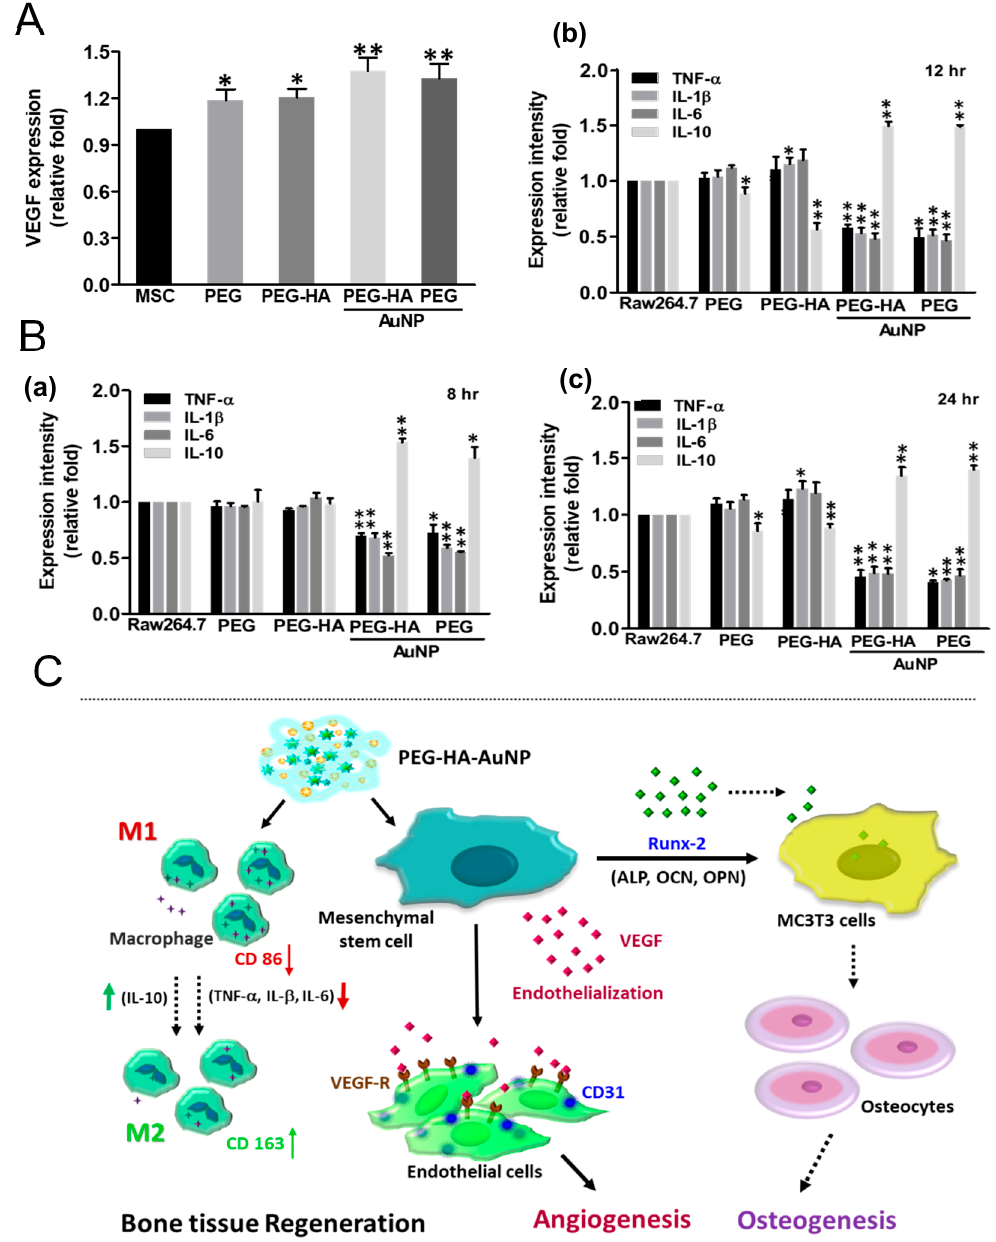
Figure 8. Assessment of the immune response and angiogenesis of MSCs on different materials. ( A ) Measurement by ELISA assay shows significantly increased VEGF protein expressions for MSCs after culture on different materials after 48 h of incubation. Data are mean ± SD. * p < 0.05: ** p < 0.01: greater than TCPS. ( B ) ELISA results for inflammatory cytokines: ( a ) 8 h, ( b ) 12 h, and ( c ) 24 h of production by RAW264.7 cells. * p < 0.05; ** p < 0.01. ( C ) Scheme illustrates PEG ‐